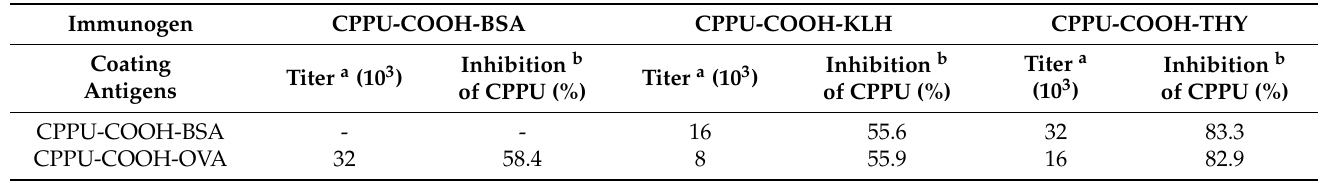
Table 1. Characterization of mice antisera against CPPU with different coating antigens.